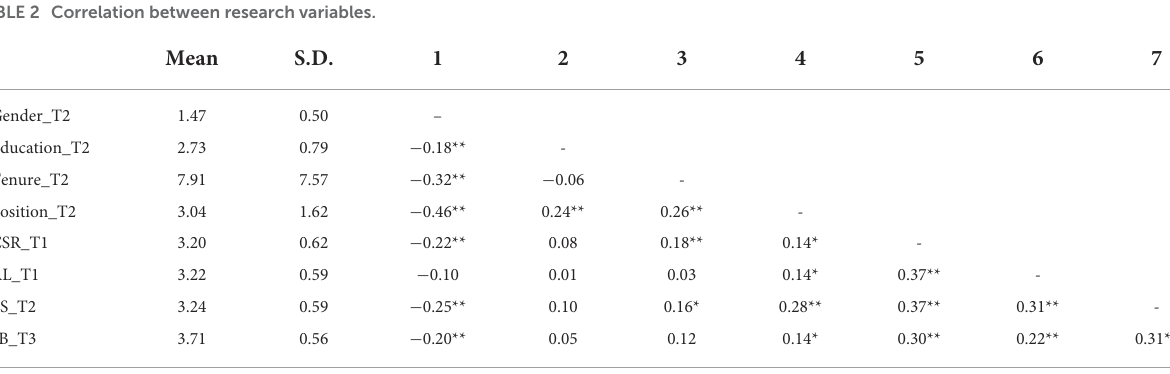
TABLE 3 Results of structural model. Hypothesis Path (relationship) Estimate S.E.